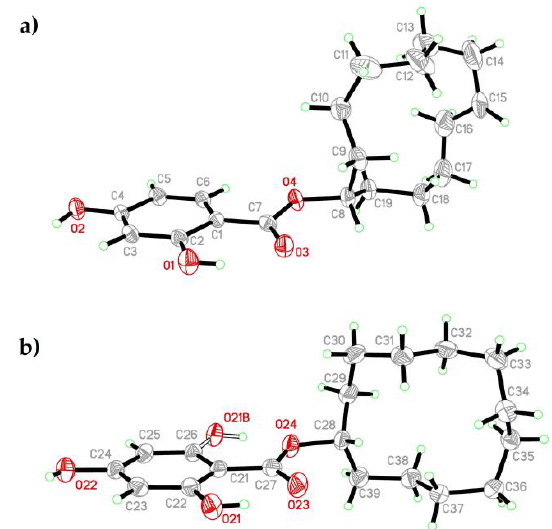
Figure 5. Crystal structures of CDHB: Molecule 1 ( a ), Molecule 2 ( b ).